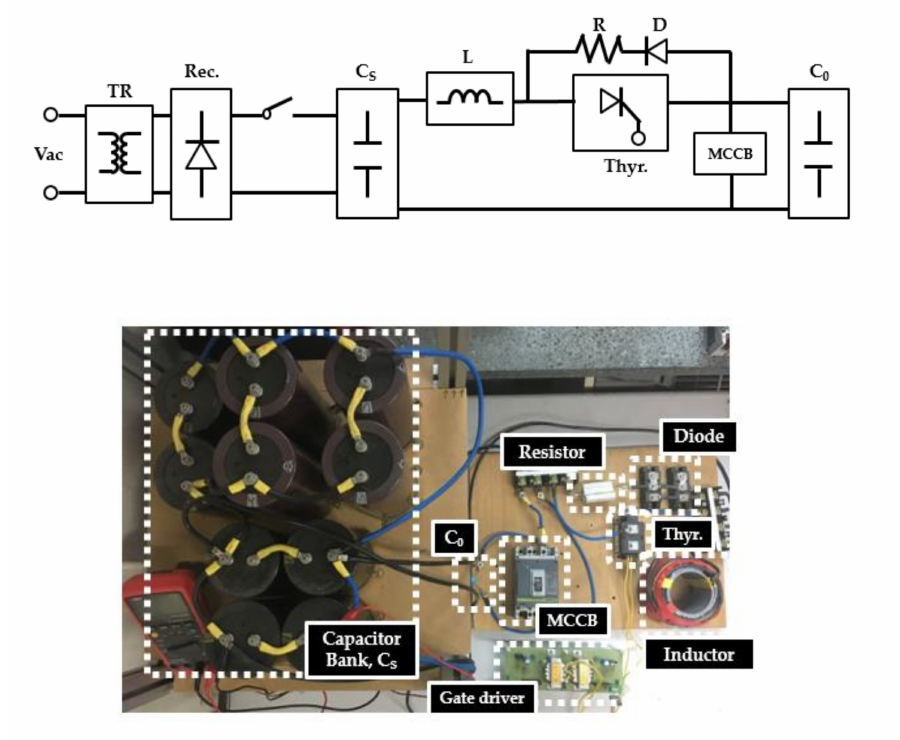
Figure 2. Experimental